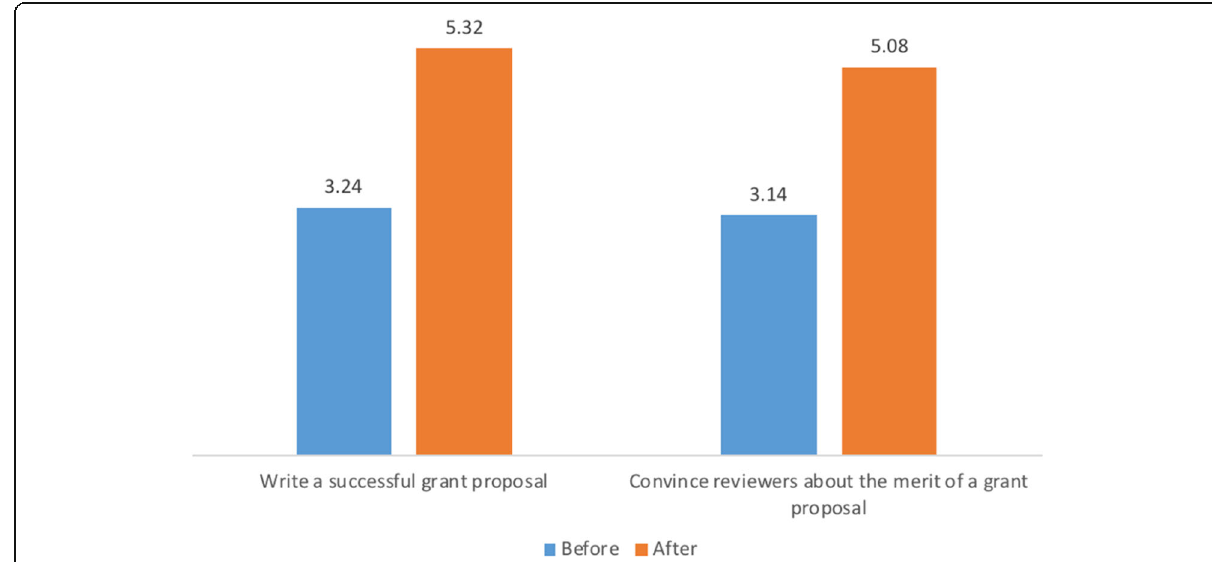
Fig. 7 Growth in confidence in